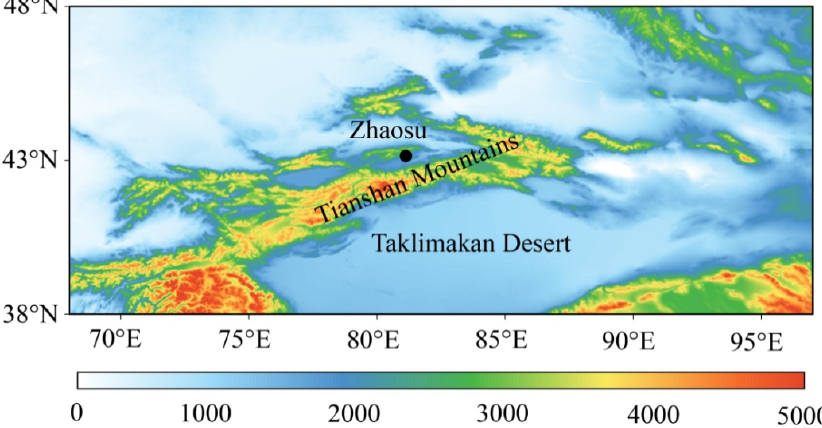
Figure 1. Location of Zhaosu (the black dot), with shading representing the topography (m) of the Tianshan Mountains.